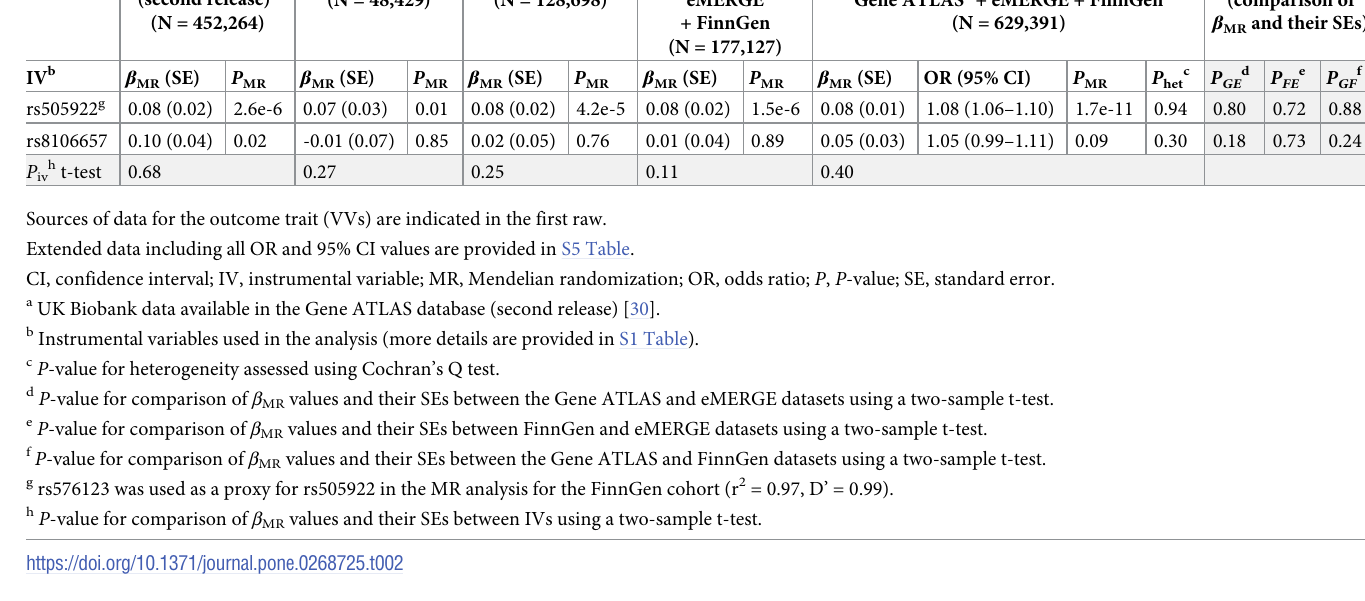
Table 2. Results of IVW Mendelian randomization analysis of the effect of CD209 plasma levels on VVs considering each selected instrumental variable separately. Gene ATLAS (second release) a